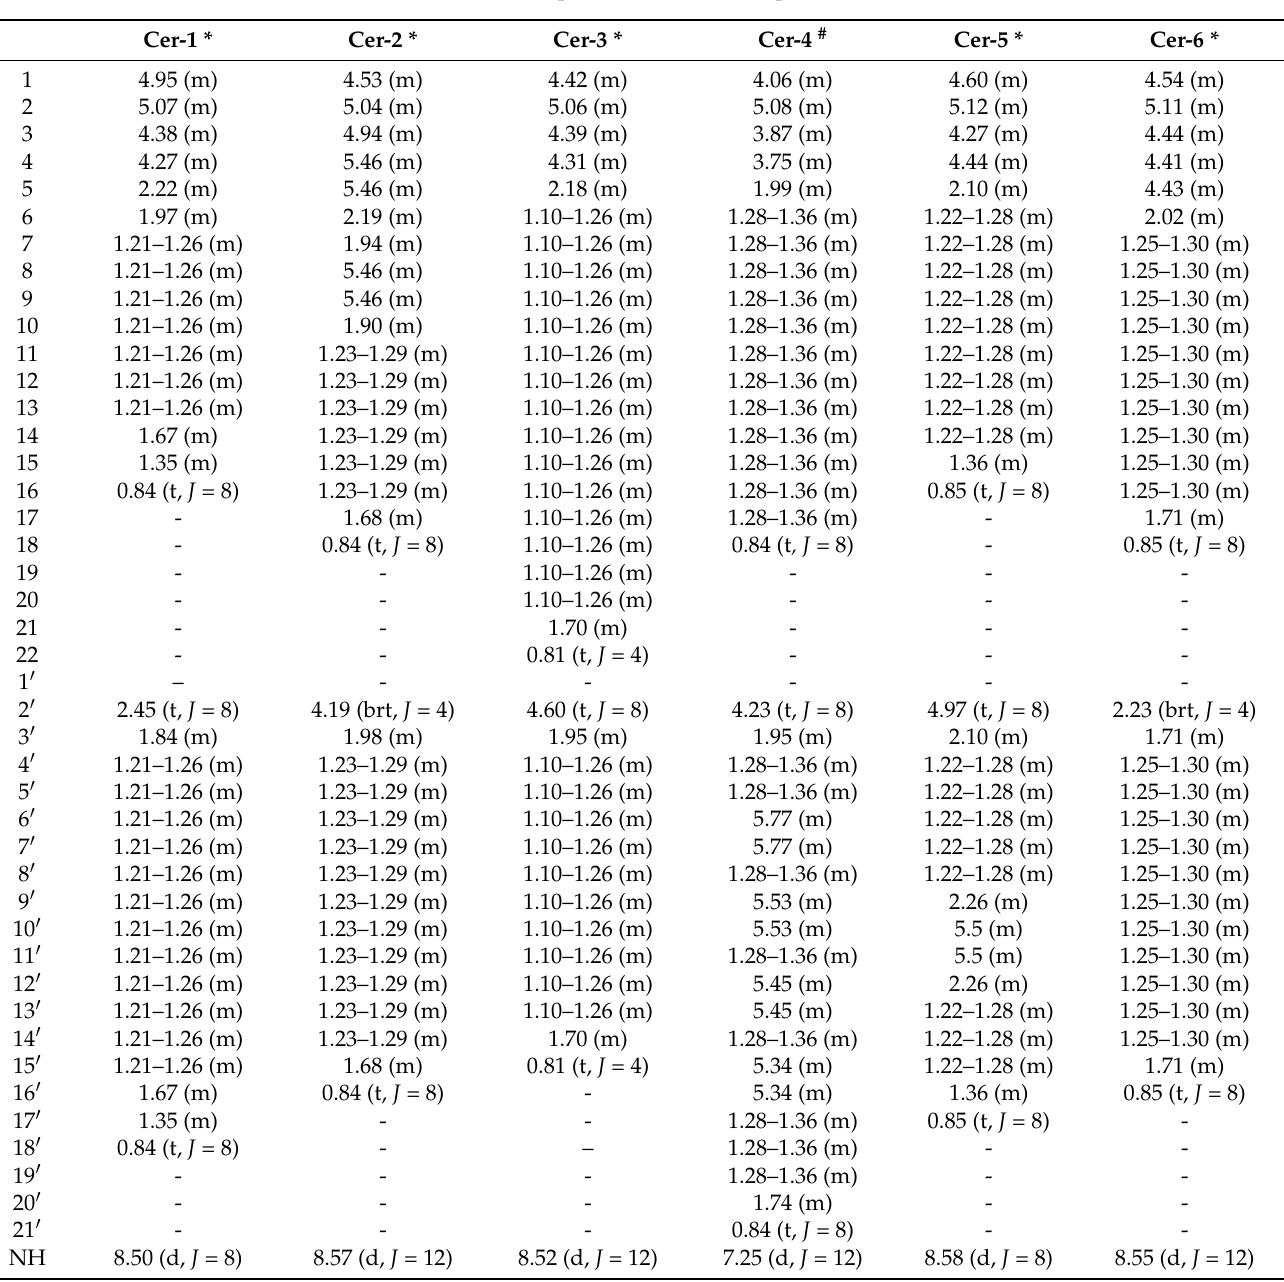
Table 2. 1 H NMR spectra of isolated compounds 1–6